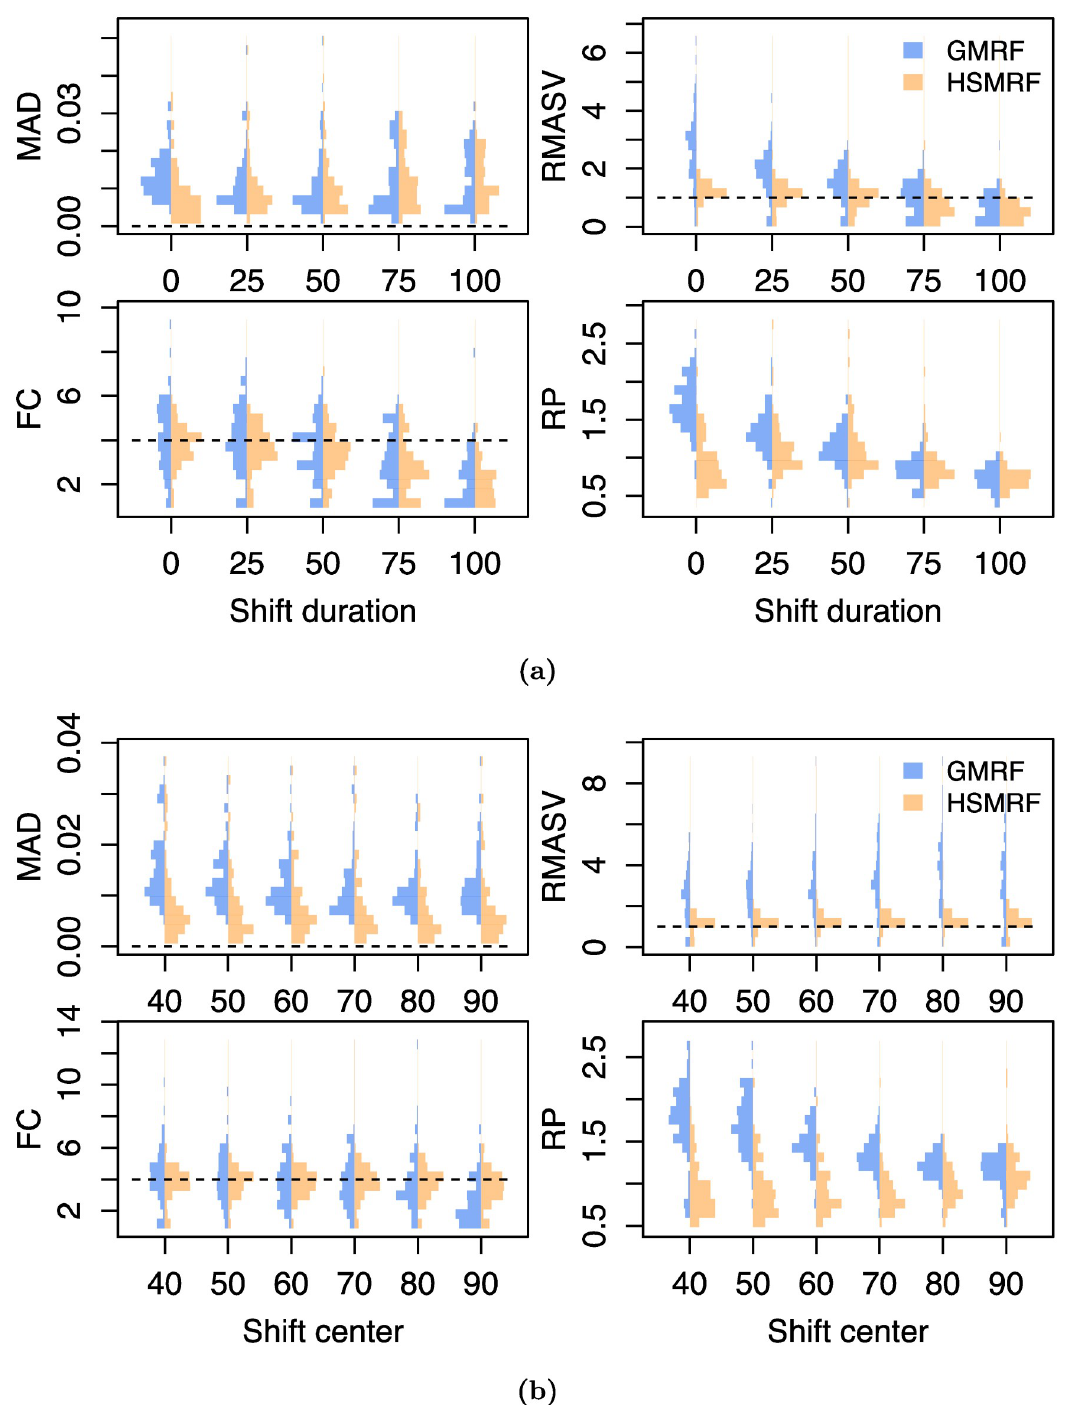
Fig 4. The effect on parameter inference of (a) changing the (four-fold) rate shift from instantaneous to the entire length of the trajectory and (b) changing the center of an instantaneous (four-fold) rate shift. MAD measures the error in the estimated trajectory. RMASV (Relative MASV) measures the total amount of change relative to the true MASV, horizontal line at 1 for reference. FC measures the fold change from present to past, dotted line at true value for reference. RP is a measure of precision, the average width of the 90% Credible Interval relative to the birth